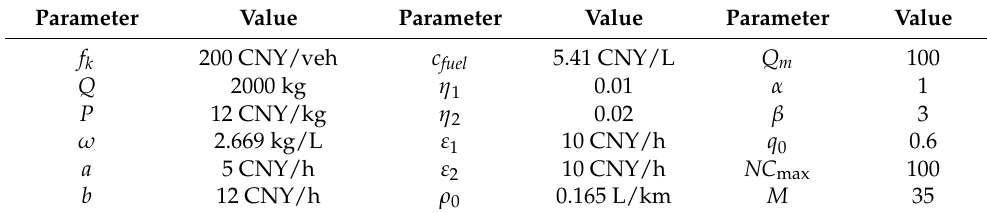
Table 1. Values of parameters in the model and optimization.